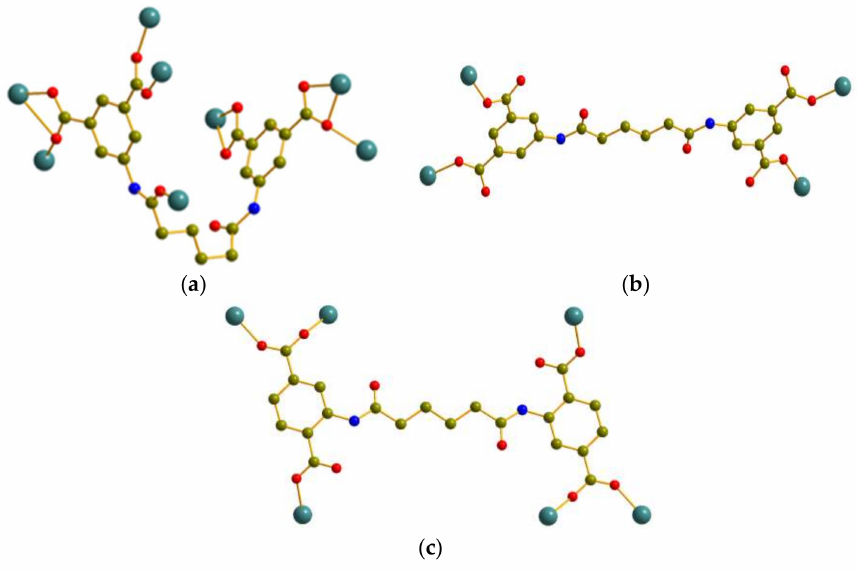
Figure 4. Various coordination modes of tetracarboxylate ligands: ( a ) ( L 1 ) 4 − in 1 , ( b ) ( L 1 ) 4 − in 2 , ( c ) ( L 2 ) 4 − in 3